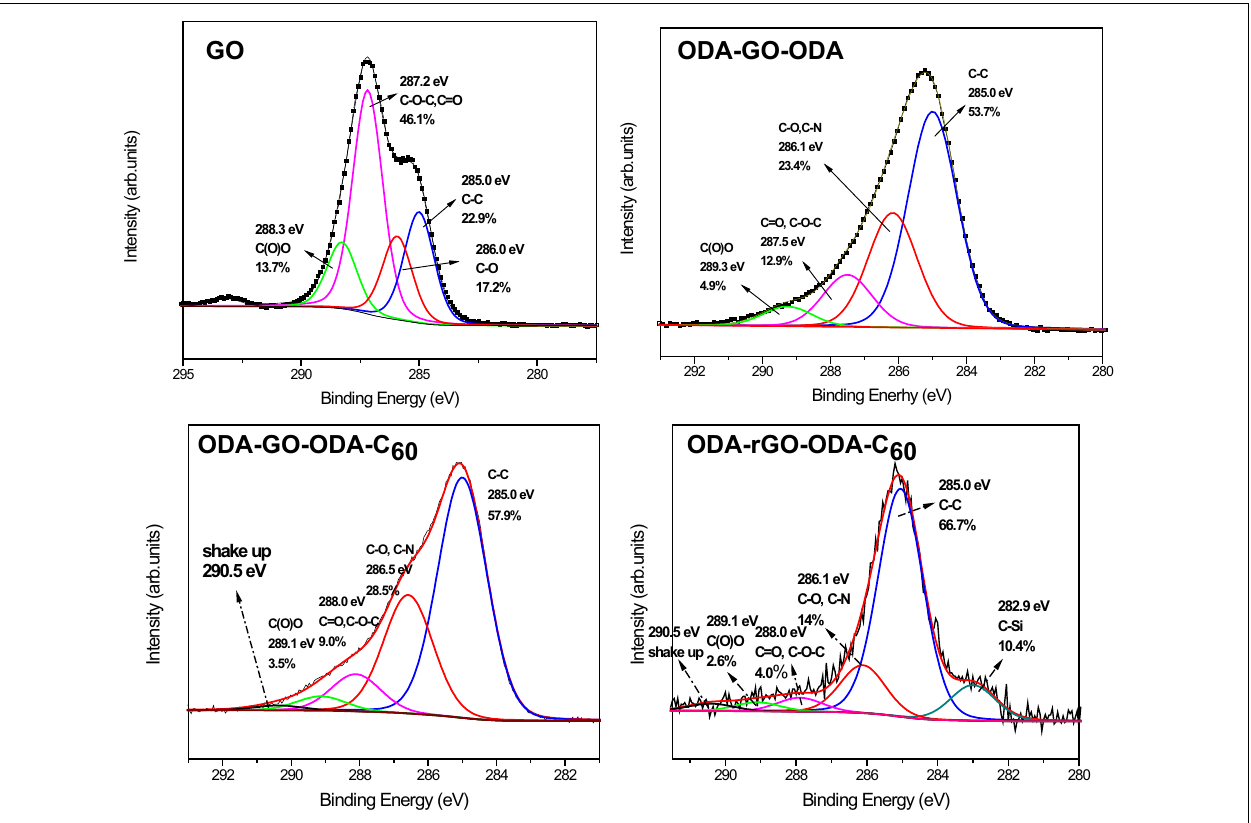
FIGURE 5 | X-ray photoelectron spectra of the C 1s core level region of GO, ODA–GO–ODA and graphene/fullerene hybrid multilayers (40 layers) before (ODA–GO–ODA–C 60 ) and after reduction and annealing (ODA–rGO–ODA–C 60 )